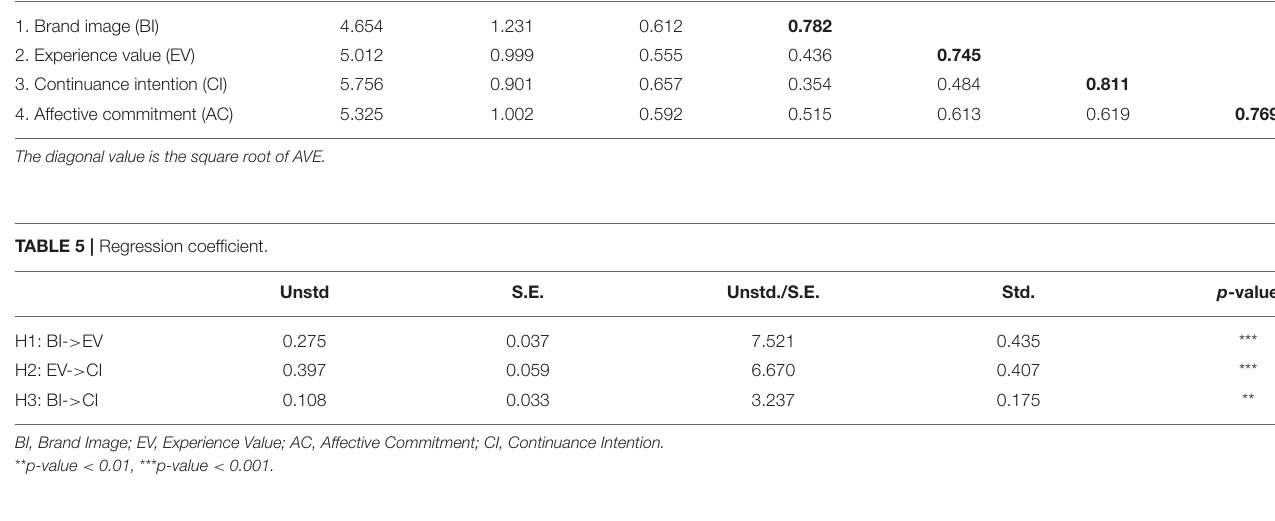
TABLE 4 | Discriminant validity for the measurement model. Variables Mean SD AVE